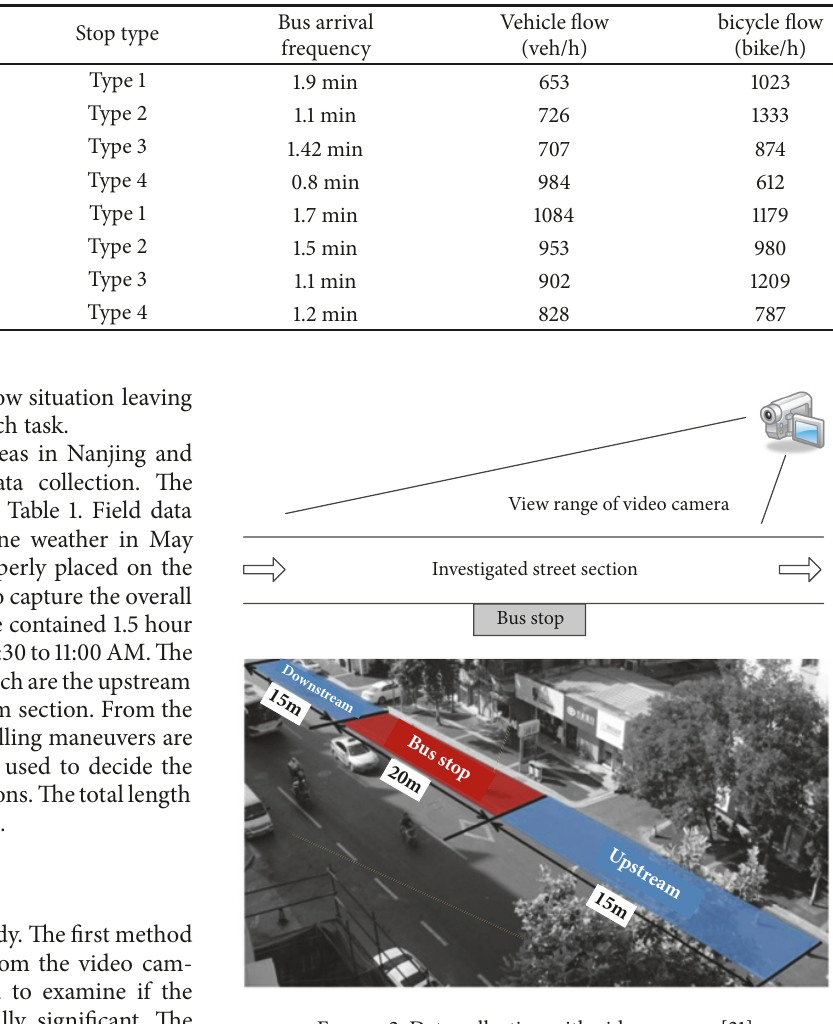
Figure 2: Data collection with video camera